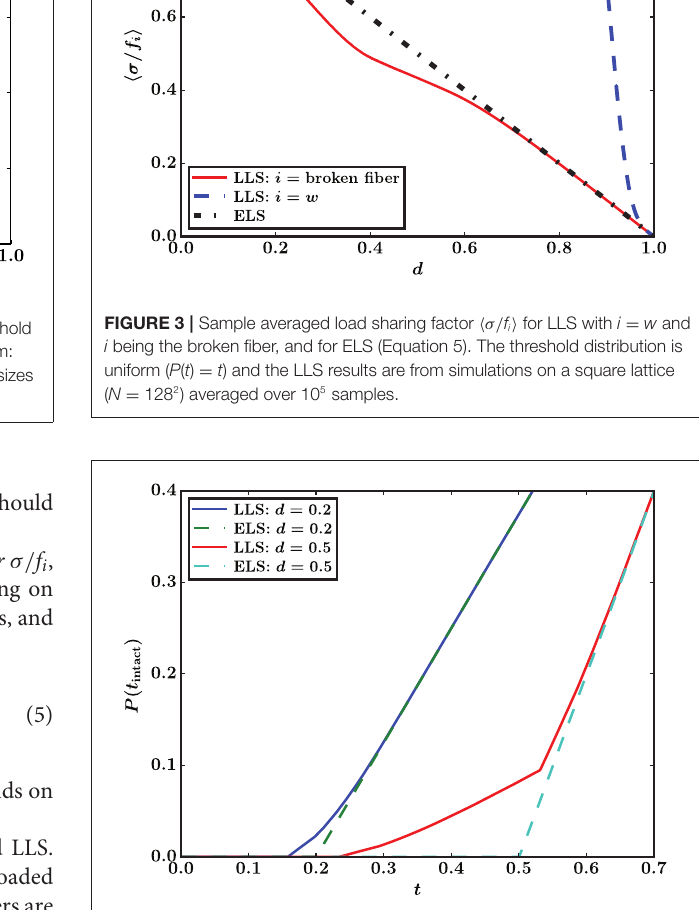
FIGURE 4 | Cumulative distribution P ( t intact ) of fiber thresholds of intact fibers at two different damages d for a single sample ( N = 1,024 2 ). LLS results are from a simulation on a square lattice, ELS results are calculated using the same thresholds as in the LLS simulation. The threshold distribution of all fibers is uniform: P ( t ) = t